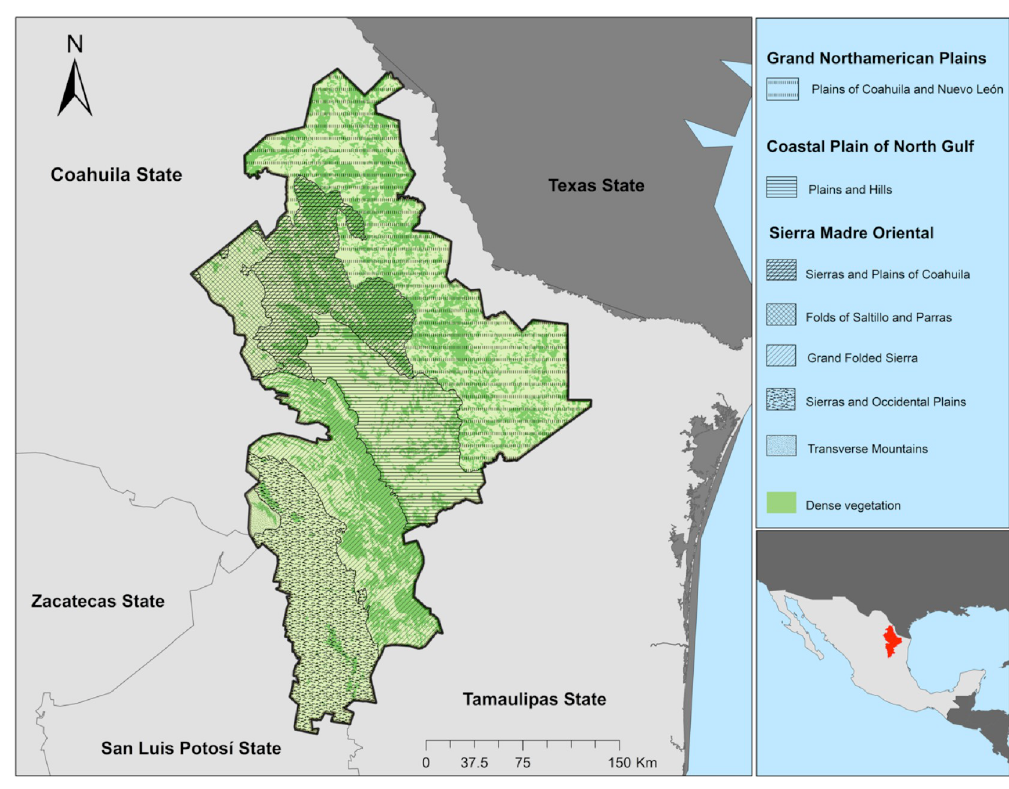
Fig 1. Physiography of Nuevo Leo´n state.